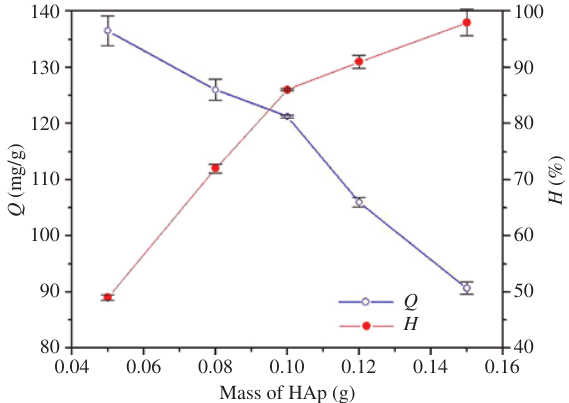
Figure 7: Effect of HAp mass on its adsorption capacity and